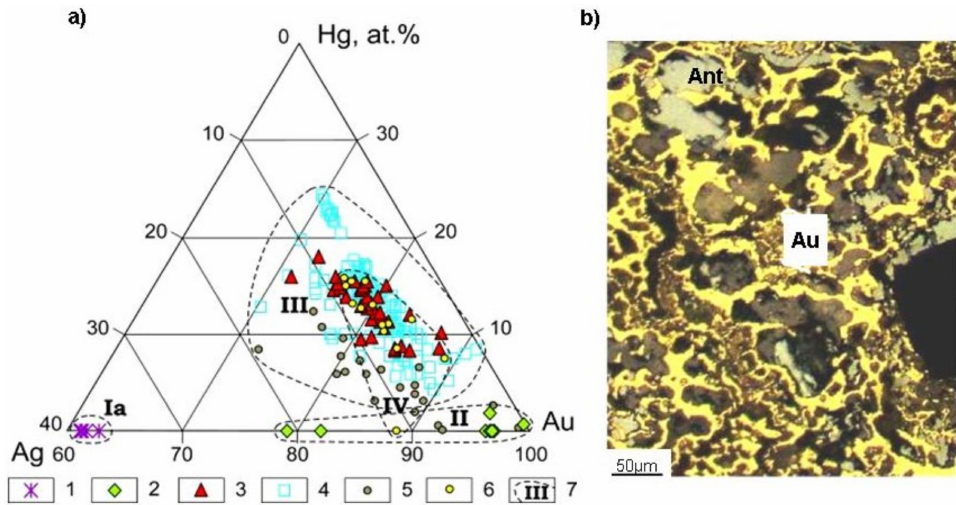
Figure 15. Typomorphic features of native gold (gold–antimony–mercury) GIT: ( a ) Ag-Hg-Au diagram of native gold of the Kyuchus deposit. The image was constructed by the authors of the present paper using data from [54]; ( b ) spongy gold intergrown with antimonite, Sarylakh